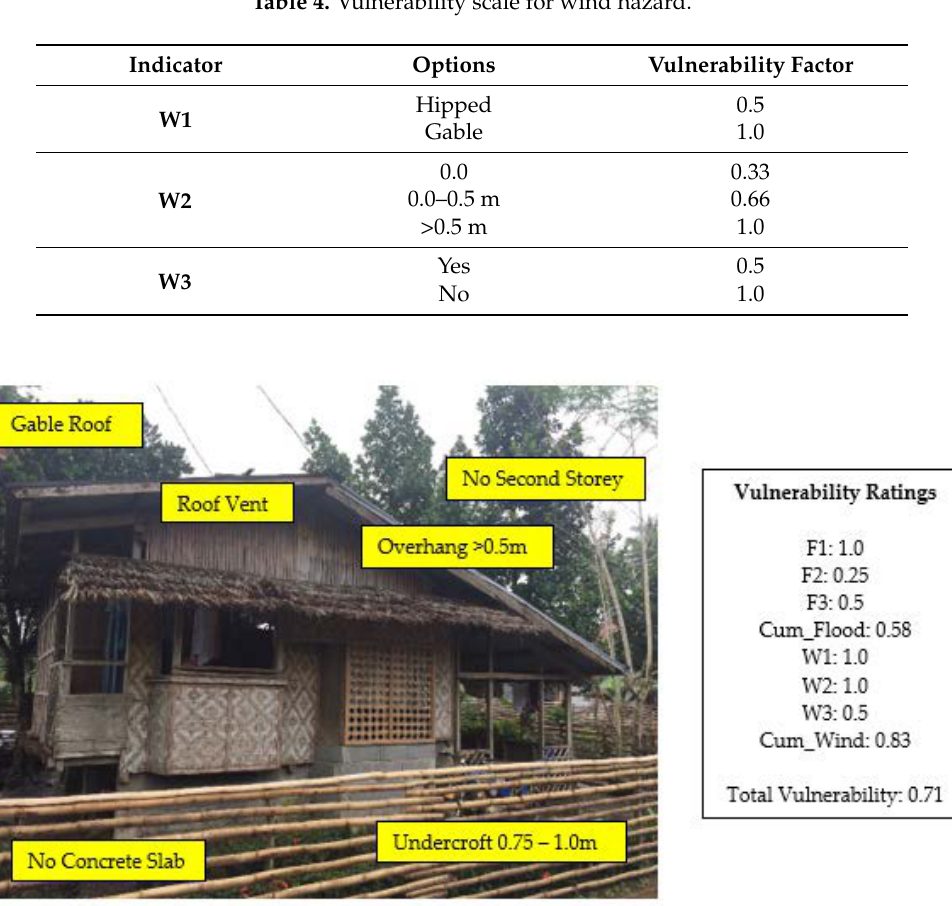
Table 4. Vulnerability scale for wind hazard.